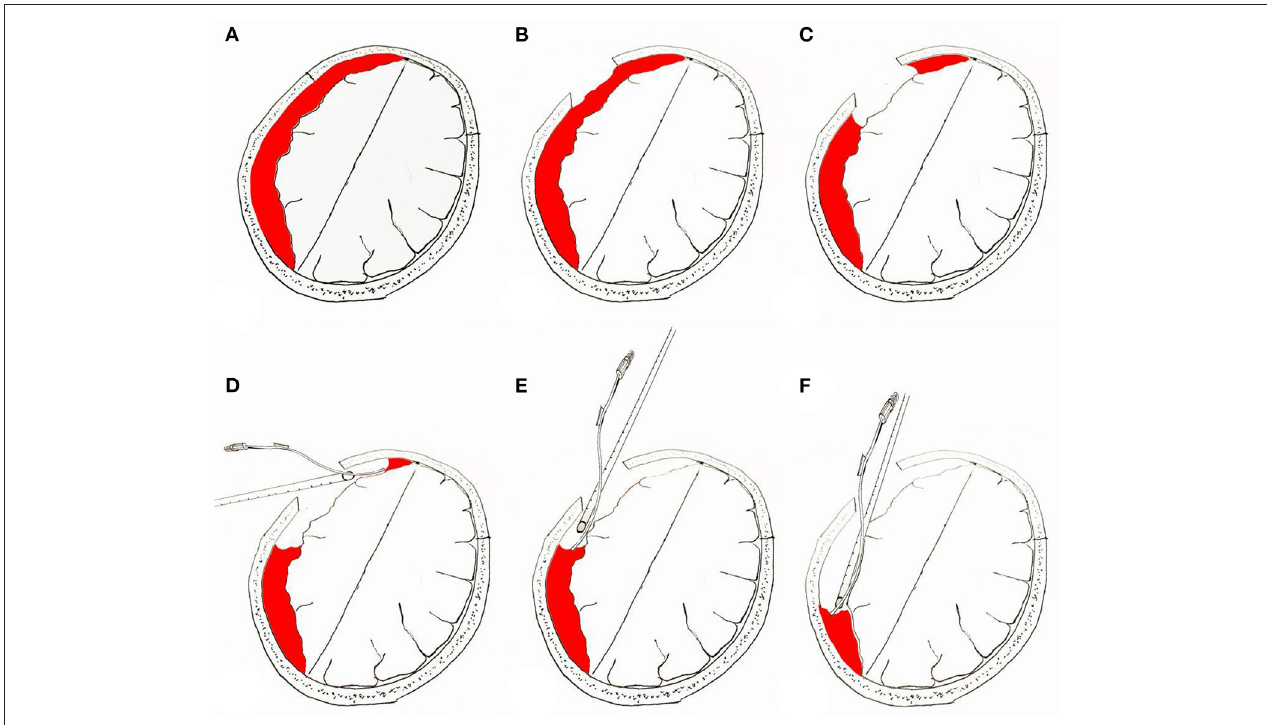
FIGURE 4 | Surgical procedure for neuroendoscopic removal of septated chronic subdural hematoma. (A) Prior to neuroendoscopic removal of chronic subdural hematoma. (B) Location of bone window in the skull. (C) Removal of the hematoma under the bone window to make space for the neuroendoscope to enter the subdural space. (D–F) Hematoma clearance under neuroendoscopy; the “push” effect of the suction device is used to remove the hematoma distant from the bone